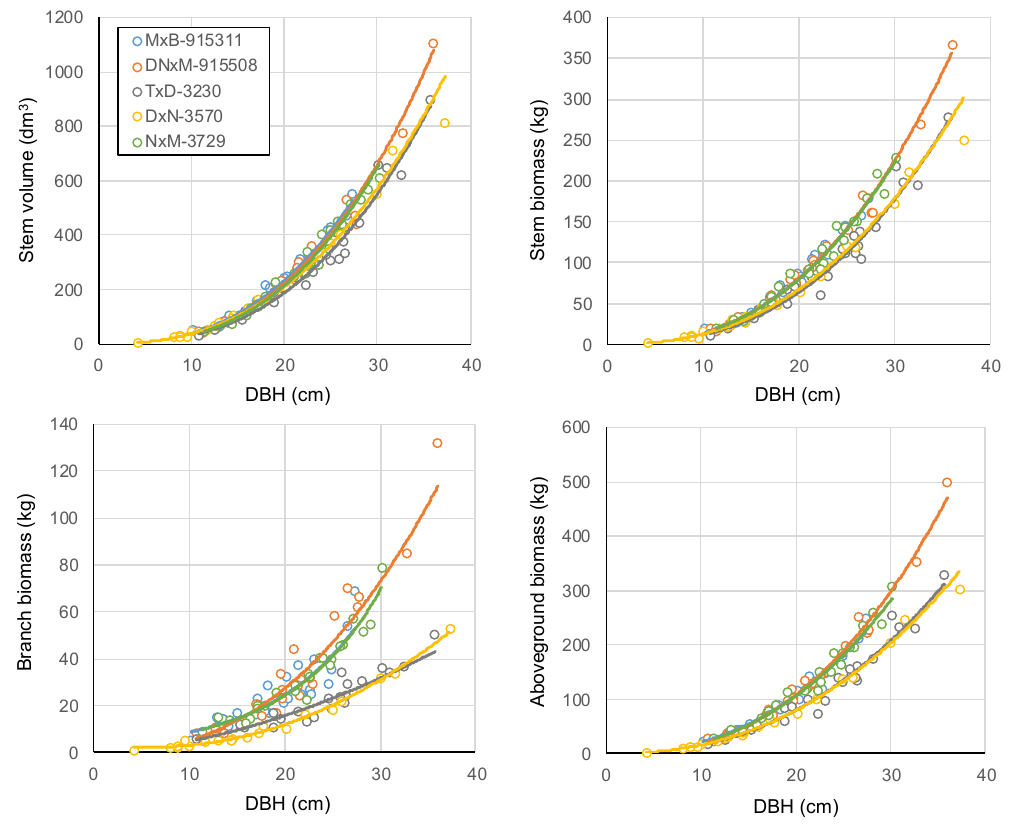
Figure 1. Clone-specific allometric relationships between diameter at breast height (cm) and stem volume (dm 3 ), stem dry biomass (kg), branch dry biomass (kg), and woody aboveground dry biomass (kg). The blue line (clone MxB-915311) is sometimes overlapped by the